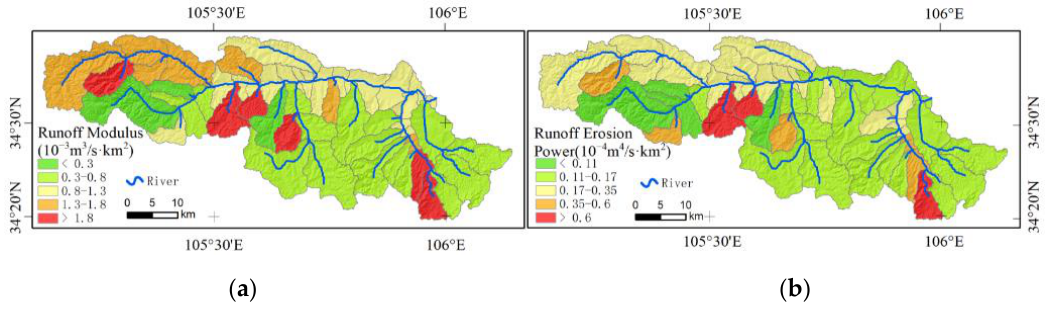
Figure 5. Spatial distribution of annual average runoff modulus ( a ) and annual average runoff erosion power ( b ) in Xihe River basin.